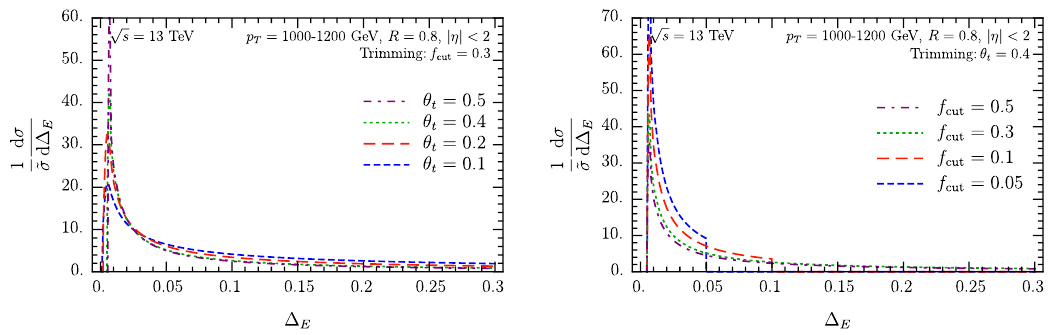
Figure 25 . Dependence of the jet energy drop for trimming on the grooming parameters θ t (left) and f cut